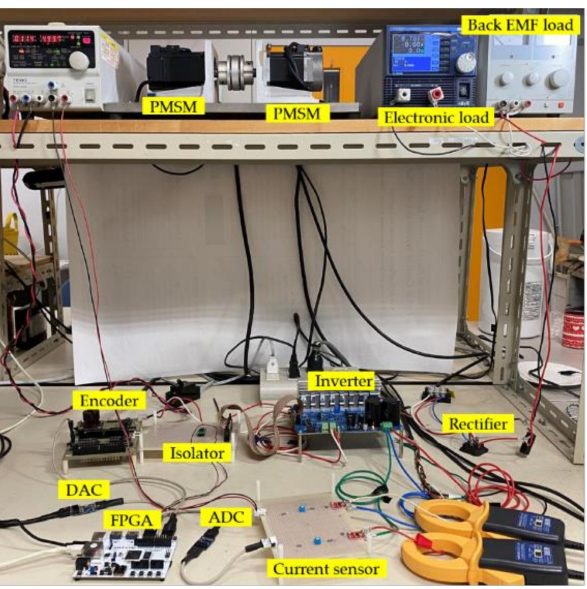
Figure 9. Experimental